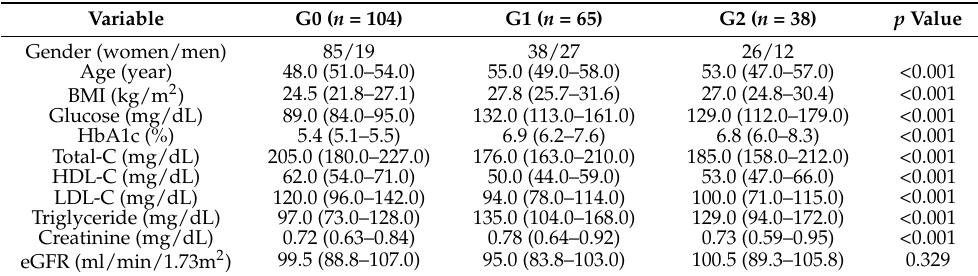
Table 1. Characteristics of study